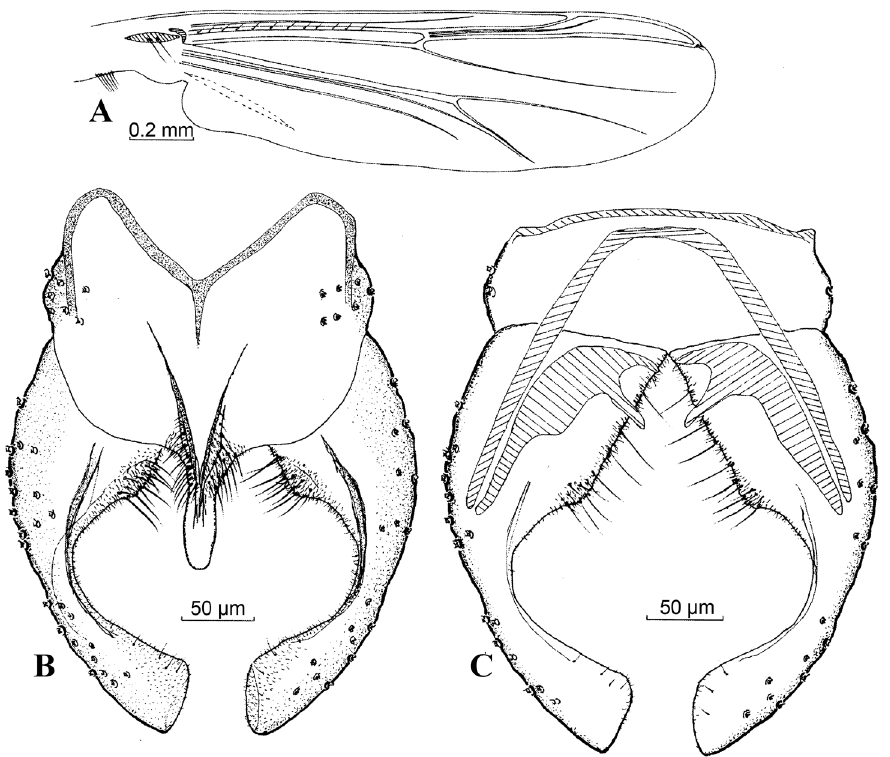
Figures 6. Harnischia japonica . A Wing; Hypopygium: B (dorsal) C